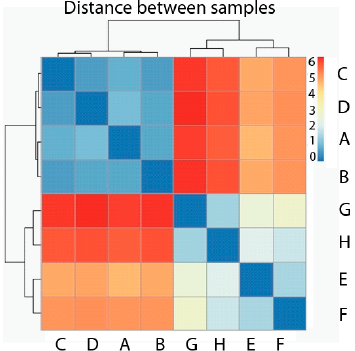
Figure 3. Heatmap Hierarchical Cluster of samples with healthy phenotype ( A – D ) and tumor phenotype ( E – H ). Pseudocolor scale shows hierarchical distance from minimum (0, blue) to maximum (6, red).